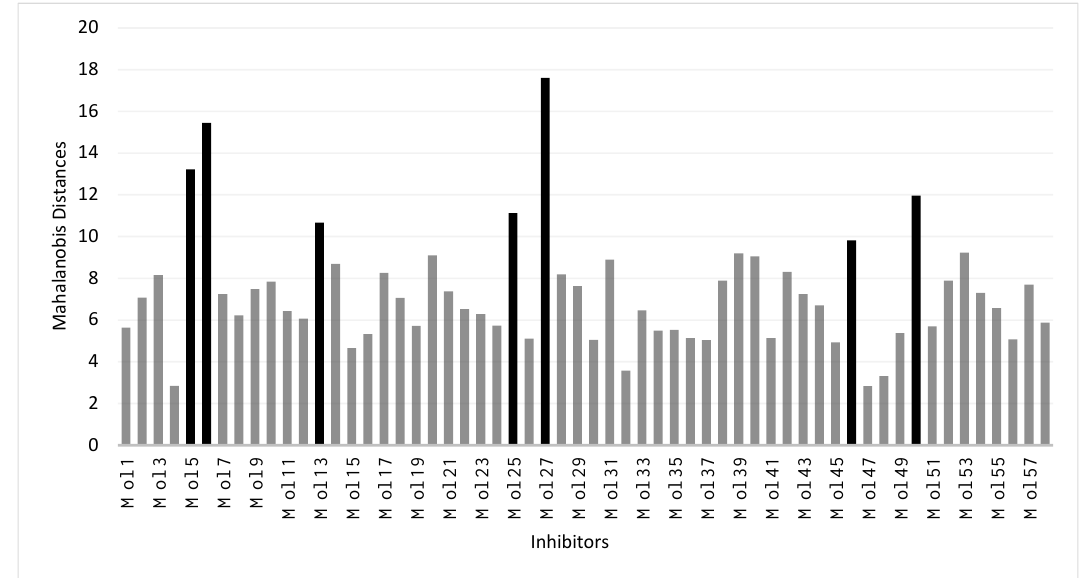
Figure 4. Calculated Mahalanobis distances of the molecules in the test set.